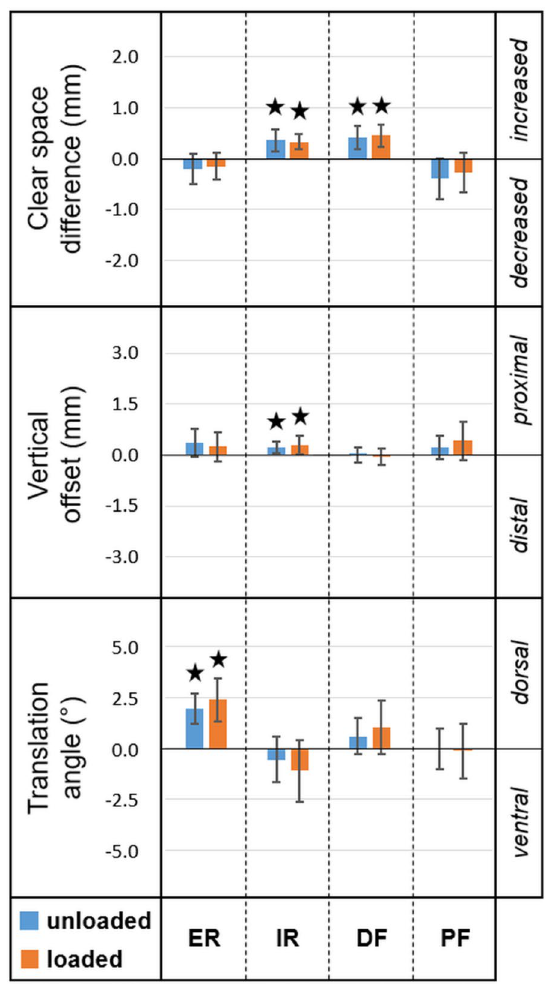
Figure 4. Clear space difference ( (cid:31) CS ), vertical offset ( (cid:31) z ), and translation angle ( �α ) for each foot position relative to neutral position in either loaded or unloaded condition. Stars indicate significant differences. Axes are scaled to corresponding thresholds for native anatomy ( � CS : ± 2mm, � z : ± 3mm, �α : ± 5 visualize relative extent of the respective measures 15